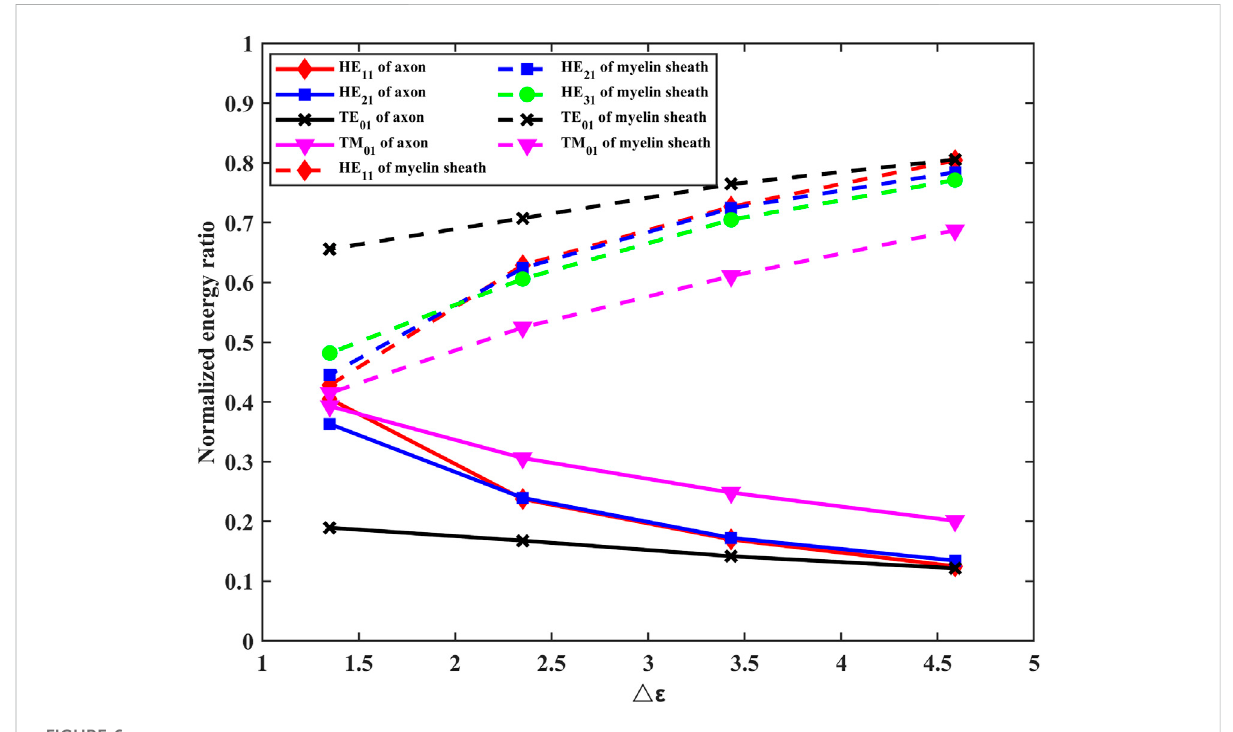
FIGURE 6 Effects of changes in the permittivity of myelin sheaths on energy distribution in axons, myelin sheaths, and fl uid